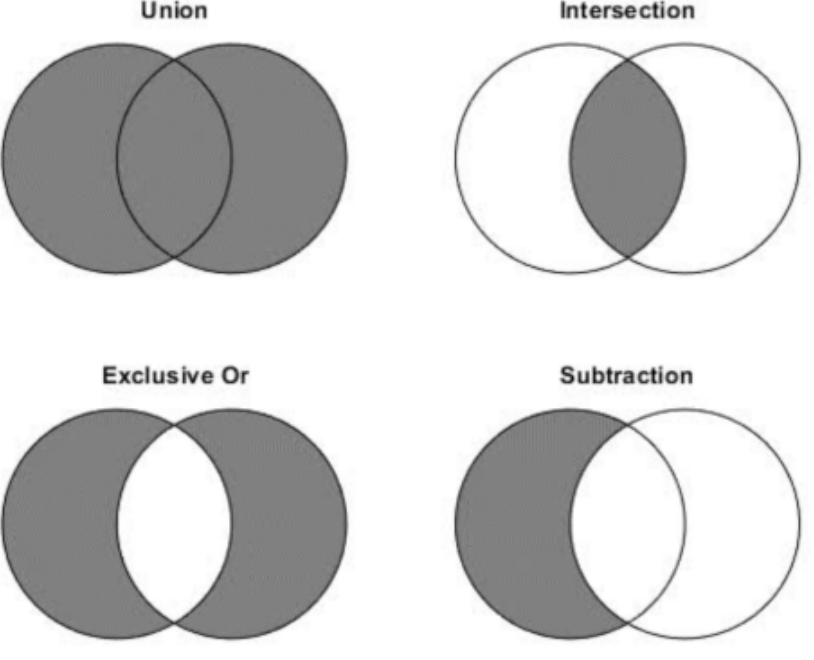
Figure 1. Four set